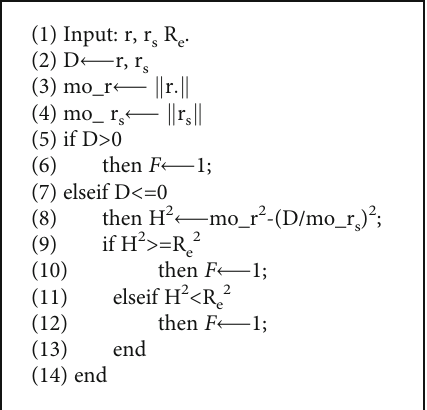
Algorithm 1: Calculate the exposure factor F